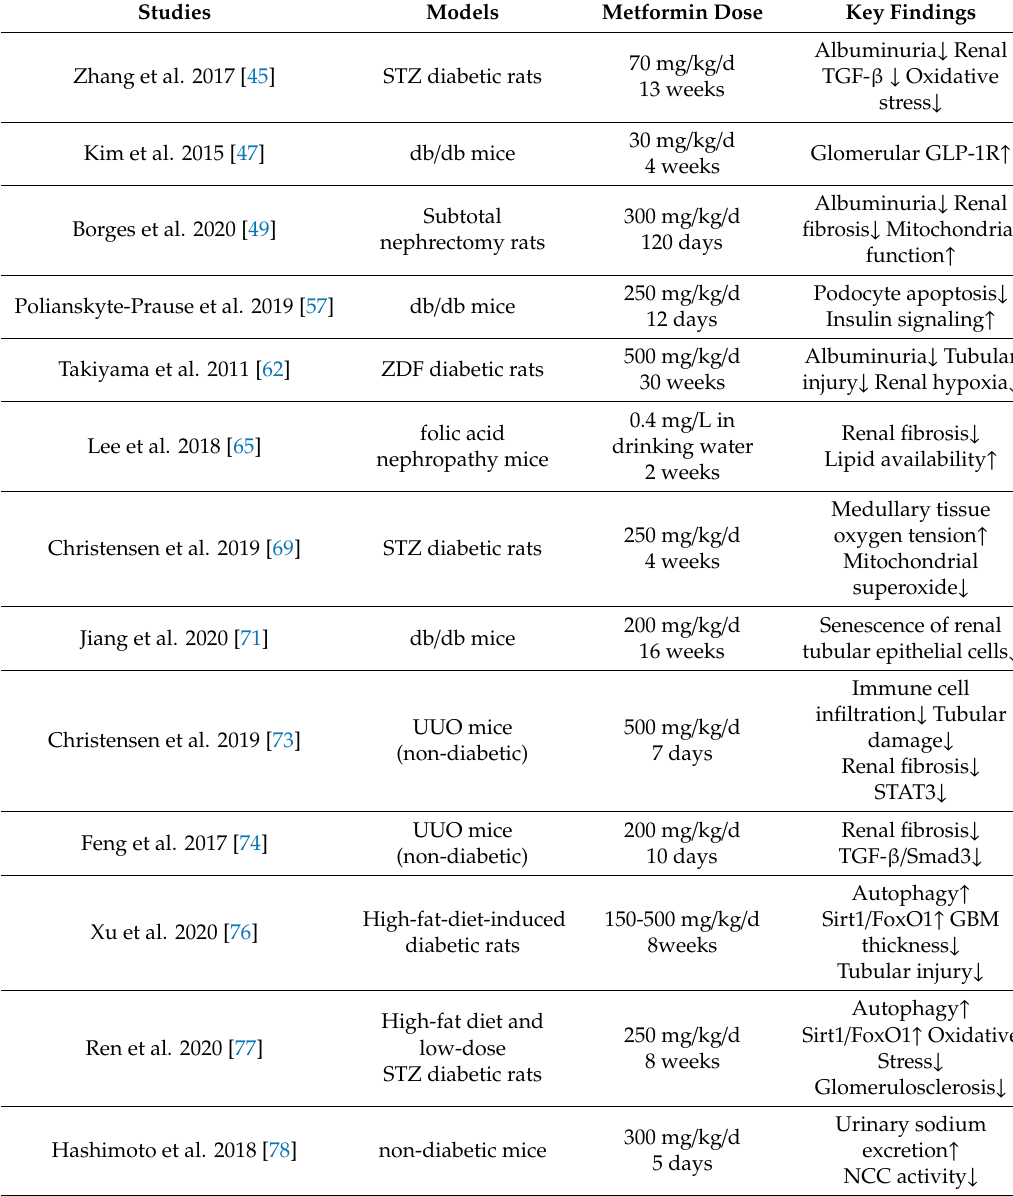
Table 1. Results of animal studies describing the renoprotective effects of metformin. The administration of metformin can reduce renal inflammation, oxidative stress and fibrosis under diabetic and non-diabetic conditions. STZ: streptozotocin, TGF- β : transforming growth factor β , db / db: C57BL / KsJ-Lepr db / Lepr db